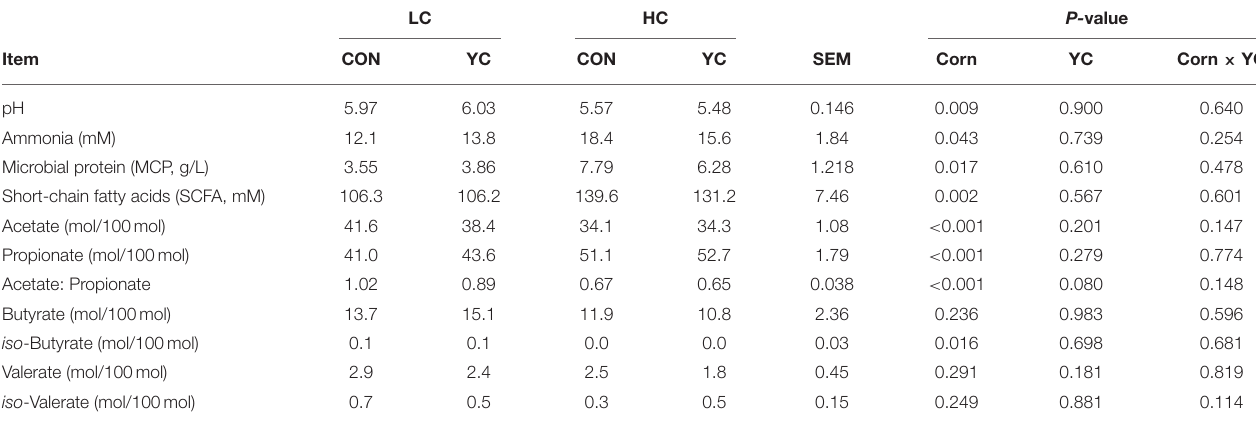
TABLE 5 | Serum biochemical parameters of fattening lambs fed experimental diets containing a low (LC) or high (HC) proportion of corn and supplemented with nil (CON) or yeast culture (YC) ( n = 6 per treatment). Item Protein metabolism Total protein (TP,